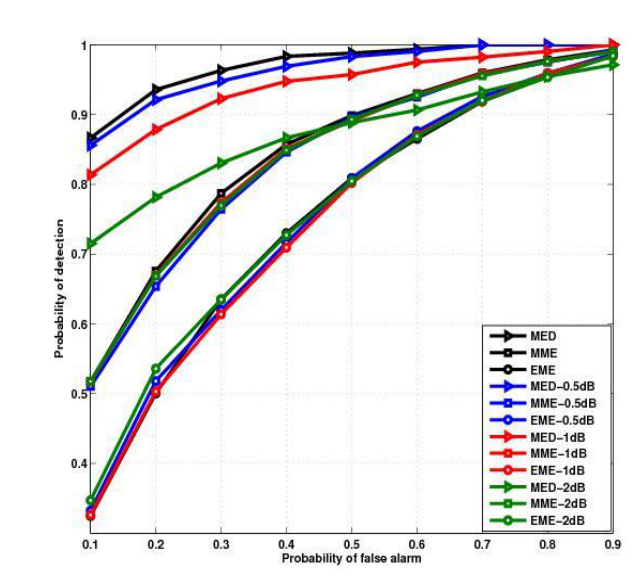
Figure 6. ROC curve at SNR=-8dB: m=4,